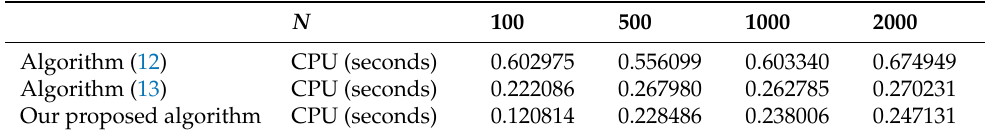
Table 1. Computation results for Example 2.